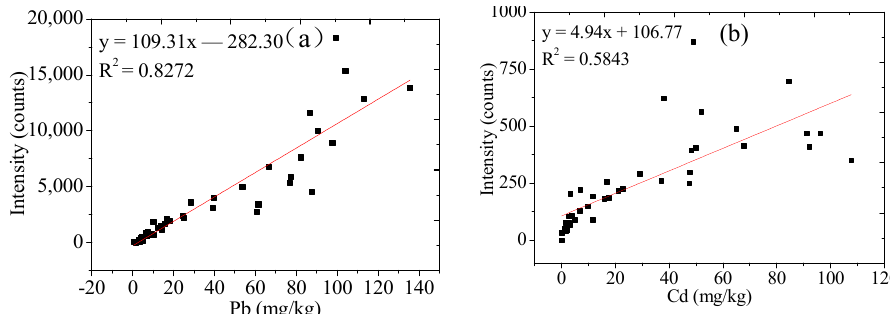
Figure 7. Calibration curve of ( a ) Pb and ( b ) Cd.